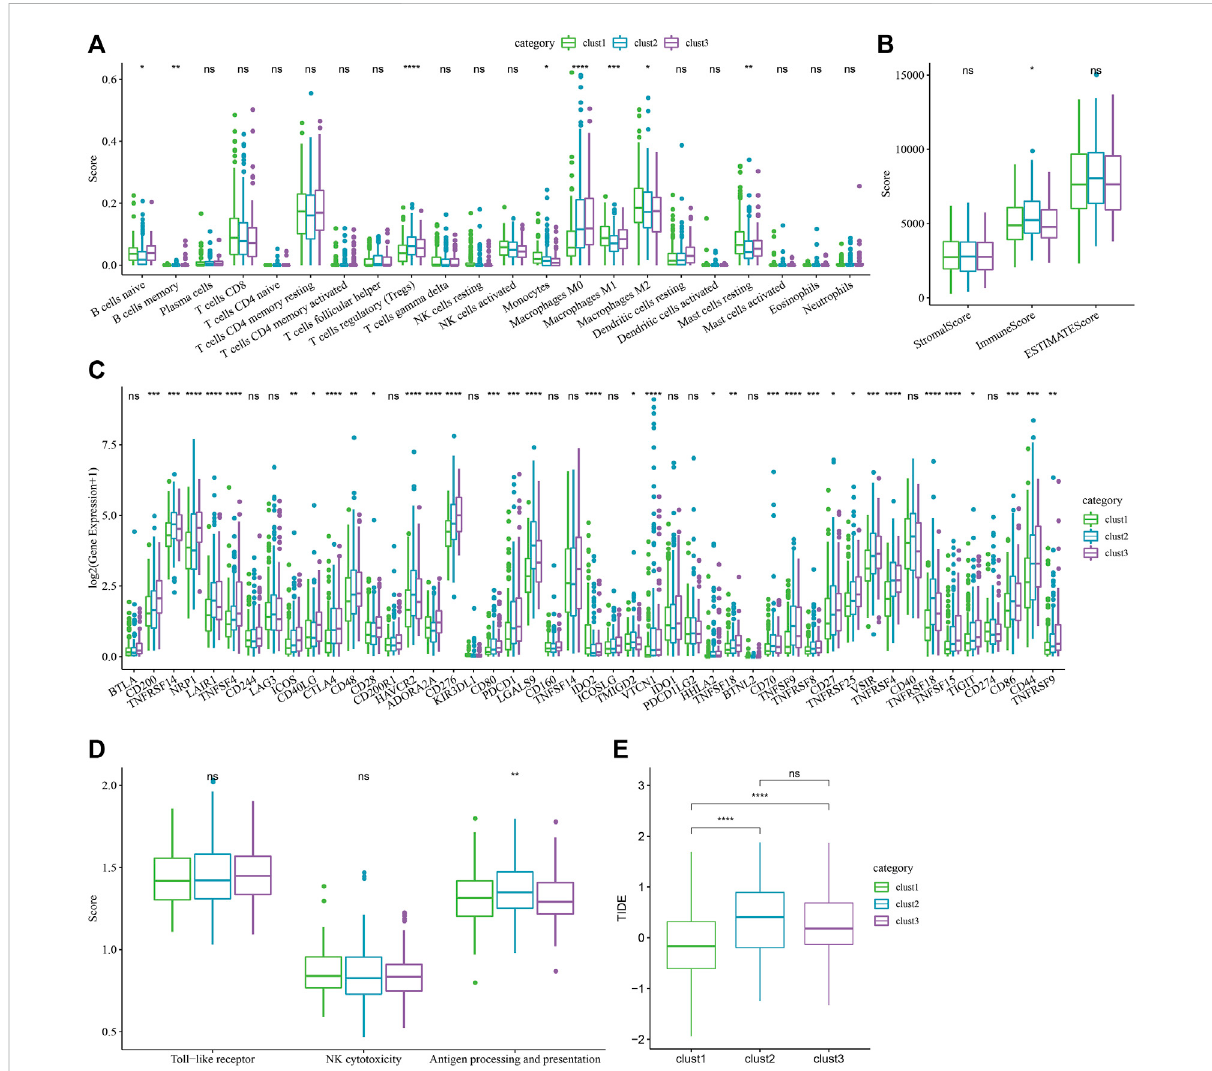
FIGURE 5 Immune-related characteristics of each cuproptosis subtype. (A) The variations in the 22 immune cell scores displayed by the 3 molecular subtypes identi fi ed using the TCGA-LIHC dataset; (B) The difference of ESTIMATE immune in fi ltration amongst the 3 molecular subtypes identi fi ed using the TCGA-LIHC dataset; (C) Immune checkpoints that were expressed differentially by the different groups in the TCGA-LIHC dataset; (D) Difference analysis of macrophage participation in related pathways between different groups in the TCGA-LIHC dataset; (ANOVA, * p <